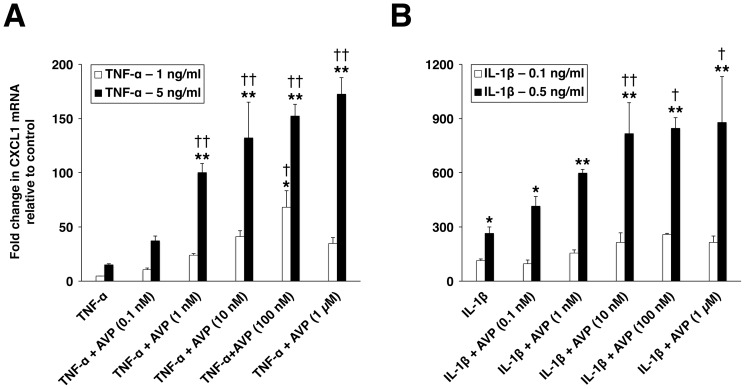
The synergistic interactions between TNF-α and AVP (A), and IL-1β and AVP (B) in the choroid plexus epithelium as assessed by real-time RT-PCR.Changes in production of CXCL1 in the choroid plexus epithelial cell line Z310 were assessed after 1-h incubation with either the cytokine (TNF-α or IL-1β) alone or a combination of the cytokine (TNF-α or IL-1β) and AVP. The exposure of Z310 cells to AVP alone at a concentration ranging between 0.1 nM and 1 µM resulted in only small increases in CXCL1 synthesis (a maximum increase observed was 6-fold relative to control with AVP at 100 nM). *p<0.05, **p<0.01 for treatment versus control. †
p<0.05, ††
p<0.01 for TNF-α + AVP versus TNF-α alone or for IL-1β + AVP versus IL-1β alone (n = 3–4 per group).